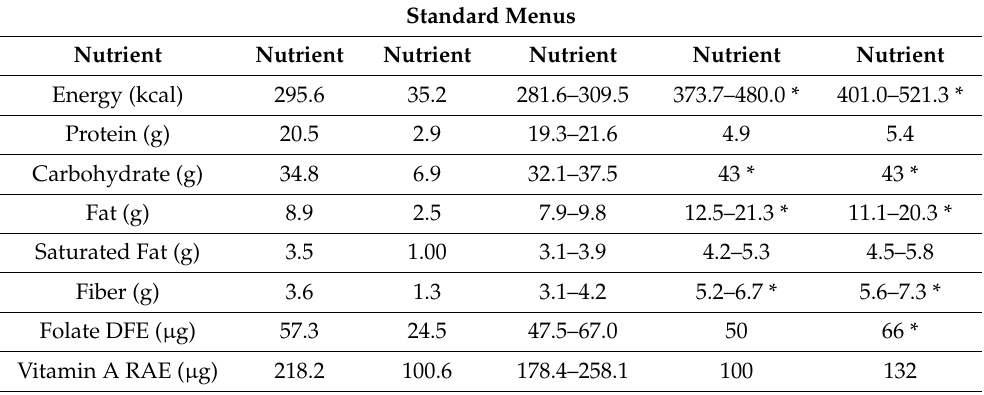
Table 3. Nutritional adequacy of the standard